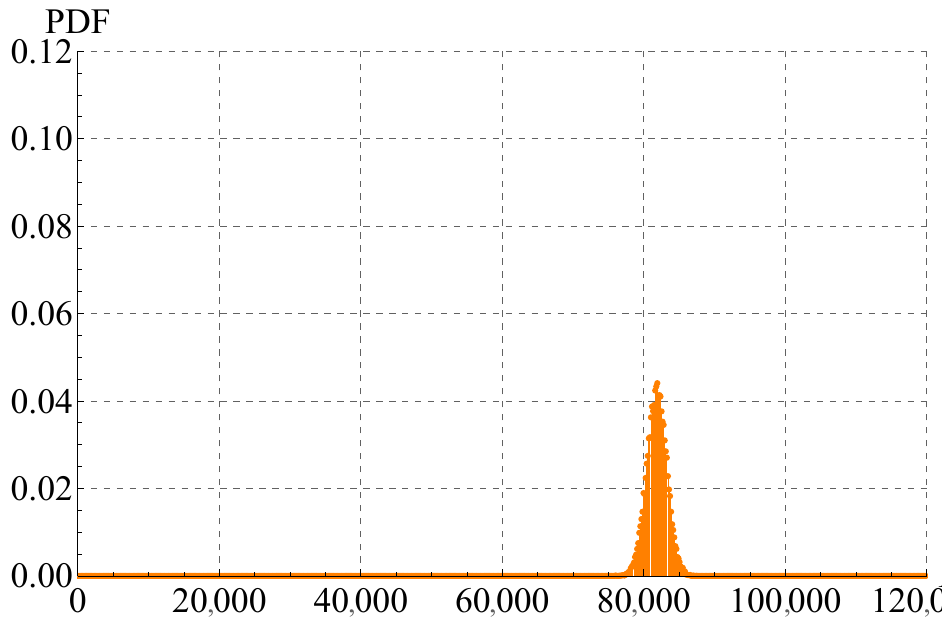
Figure 15. Probability density function (PDF), solution of Equation (36). Screenshoot at time ˆ t =